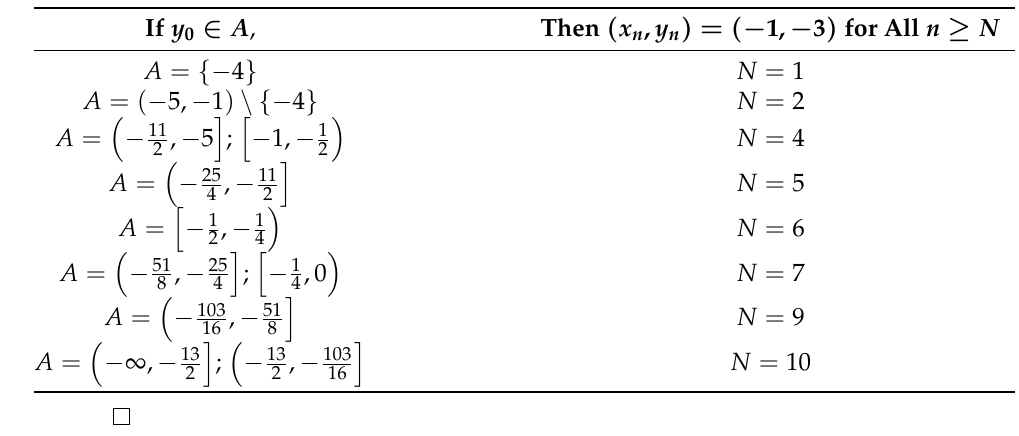
Table 6. Cases for x 0 = 0 and y 0 < 0.